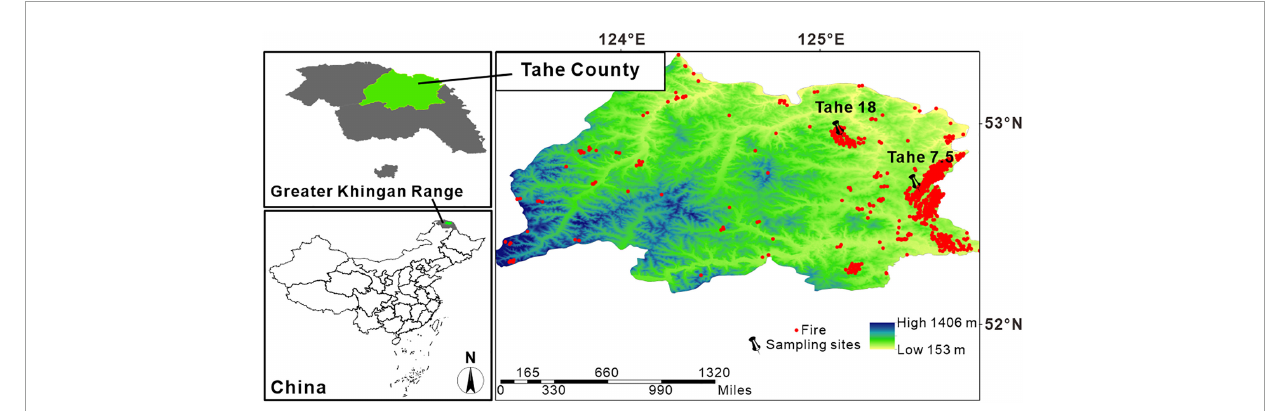
FIGURE1 Tree cores sampled from two sites in Tahe County in the Greater Khingan range of China.